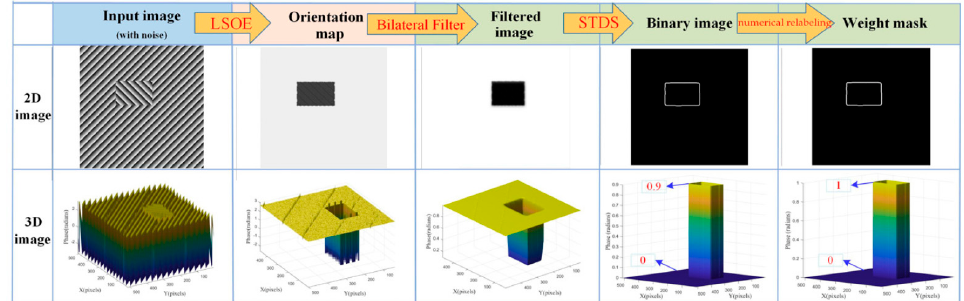
Figure 2. Flowchart of the proposed algorithm.